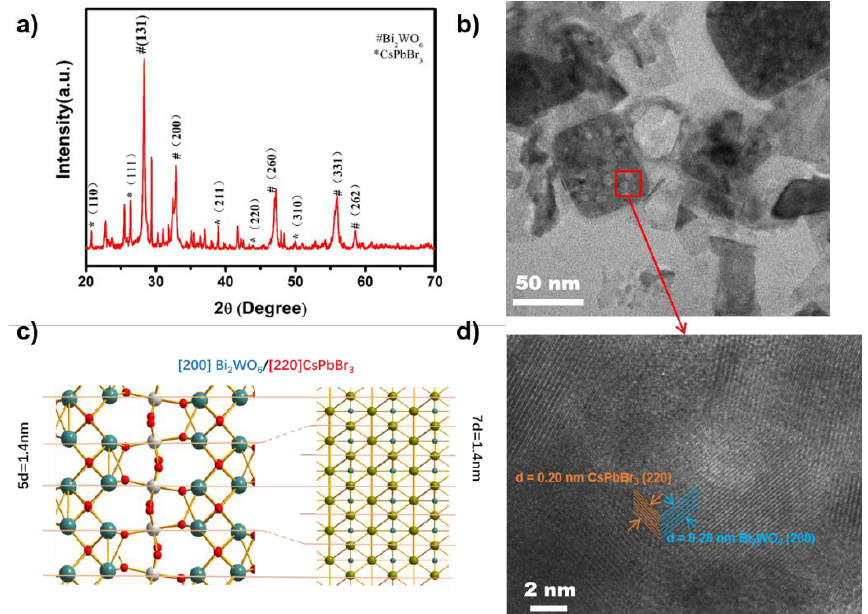
Figure 1. ( a ) PXRD patterns and ( b ) TEM image of the as-prepared 15 wt% CsPbBr 3 /Bi 2 WO 6 photocatalyst; ( c ) schematic diagram of semi-coherent interface of the two components; ( d ) HR-TEM image of the as-prepared 15 wt% CsPbBr 3 /Bi 2 WO 6 photocatalyst.